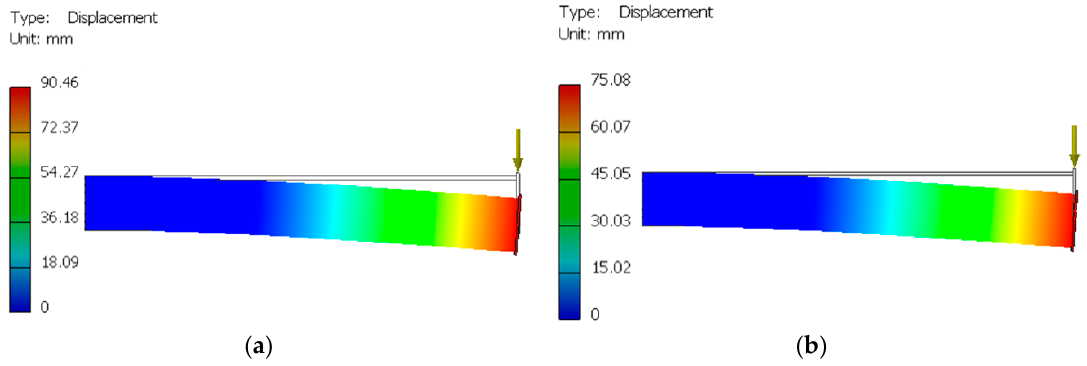
Figure 2. Flexibility analysis regarding specimen 2 of ( a ) PE 80 and ( b ) PE 100 as enlisted in Table 2.